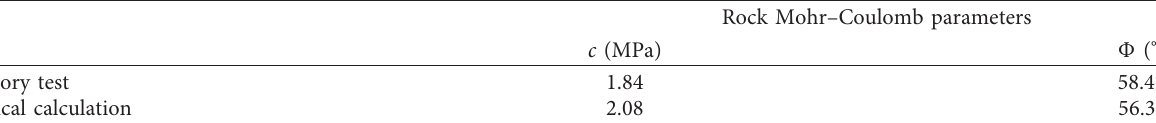
Table 3: Comparison of shear strength parameters obtained from the laboratory test and numerical calculation.